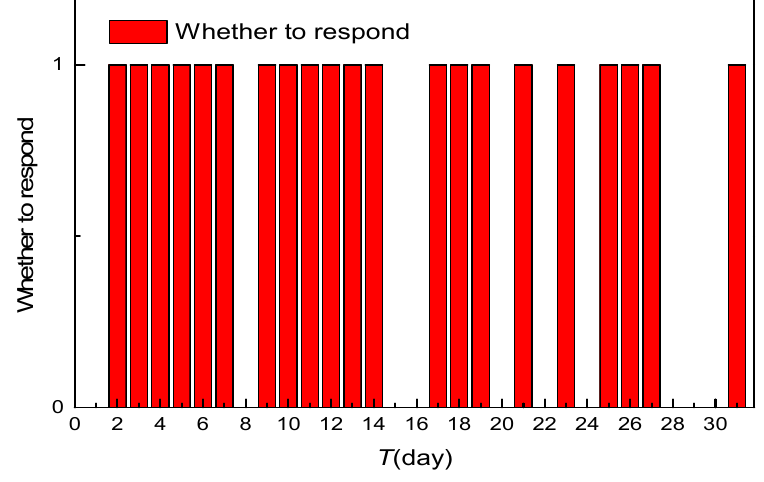
Figure 14. Short-term response of electric vehicle users.